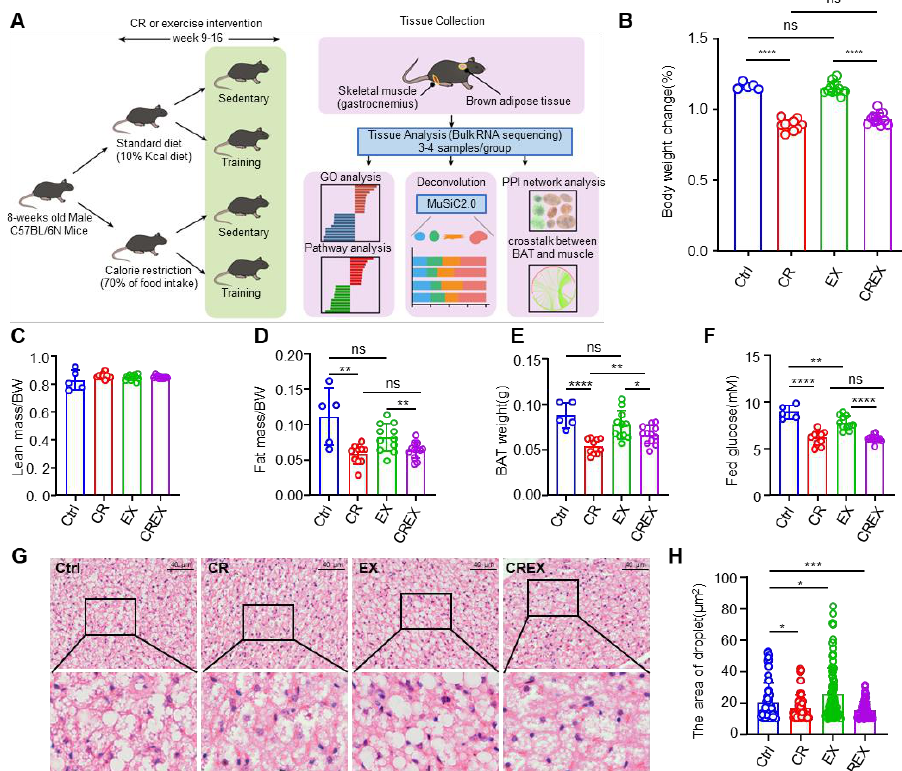
Figure 1. Study overview and phenotypic responses. ( A ) Overview of the mouse study and tissue profiling. ( B – F ) Body weight change ( B ), ratio of lean mass to body weight ( C ), ratio of fat mass to body weight ( D ), BAT weight ( E ) and fed glucose ( F ) in the four intervention groups. ( G ) Representative hematoxylin and eosin staining images of BAT (scale bars, 40 μm). ( H ) Areas of the droplets from H&E staining images of BAT. Statistical comparisons were carried out using unpaired one-tailed t tests or Wilcoxon rank sum and signed rank tests ( B – F , H ). Data are represented as means ± SD. * p < 0.05, ** p < 0.01, *** p < 0.001,**** p < 0.0001; ns, not significant; BW, body weight; CR, calorie